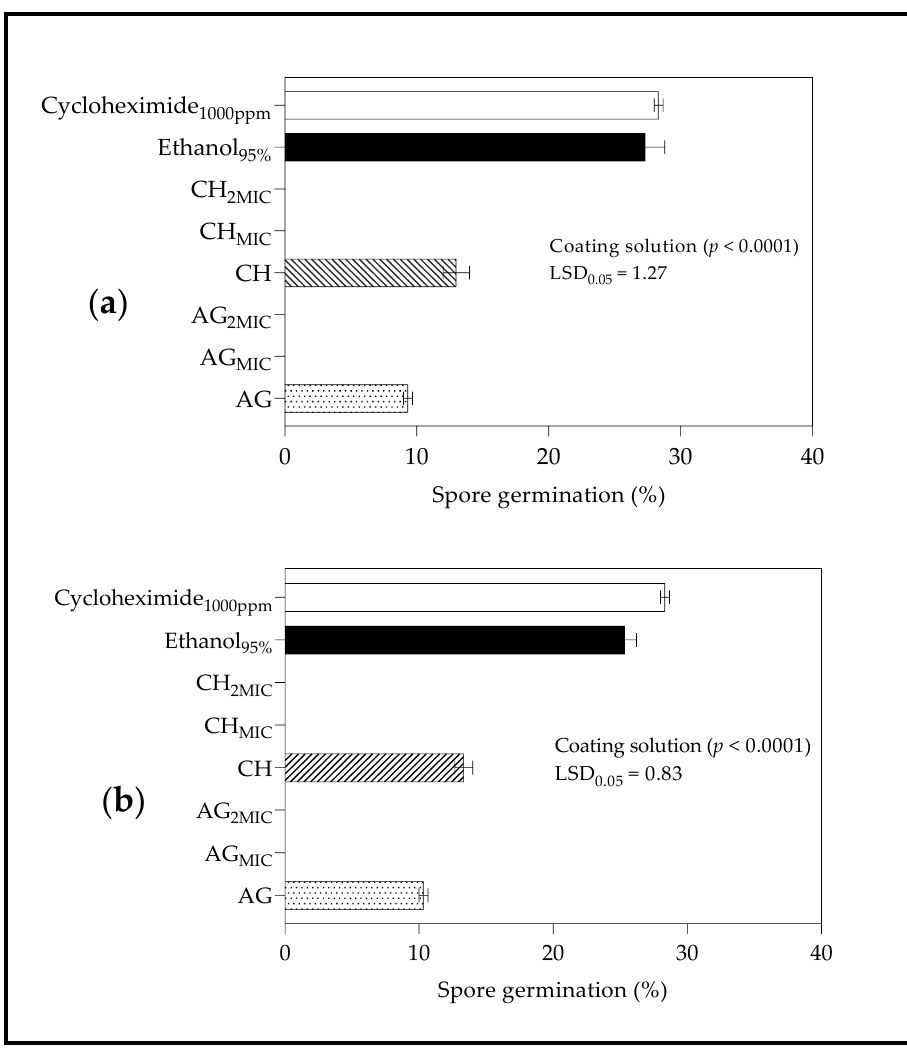
Figure 4. Effect of edible coating solutions on spore germination (%) of ( a ) Botrytis cinerea ( b ) Peni- cillium spp. after 24 h of incubation at 22 °C ( B. cinerea ) or 25 °C ( Penicillium sp.). MIC — minimum inhibitory concentration; 2MIC — double the minimum inhibitory concentration. B. cinerea (MIC = 15 µL/mL; 2MIC = 30 µL/mL) and Penicillium spp. (MIC = 30 µL/mL; 2MIC = 60 µL/mL); CH — chitosan; CH MIC — chitosan formulated with lemongrass oil at minimum inhibitory concentration (15 or 30 µL/mL); CH 2MIC — chitosan formulated with lemongrass oil at double the minimum inhib- itory concentration (30 or 60 µL/mL); AG — sodium alginate; AG MIC — sodium alginate formulated with lemongrass oil at the minimum inhibitory concentration (15 or 30 µL/mL); AG 2MIC — sodium alginate formulated with lemongrass oil at double the minimum inhibitory concentration (30 or 60 µL/mL). Vertical bars represent the standard error (SE) of mean values of three replicates (1 plate = replicate). LSD 0.05 represent least significant difference ( p < 0.05).